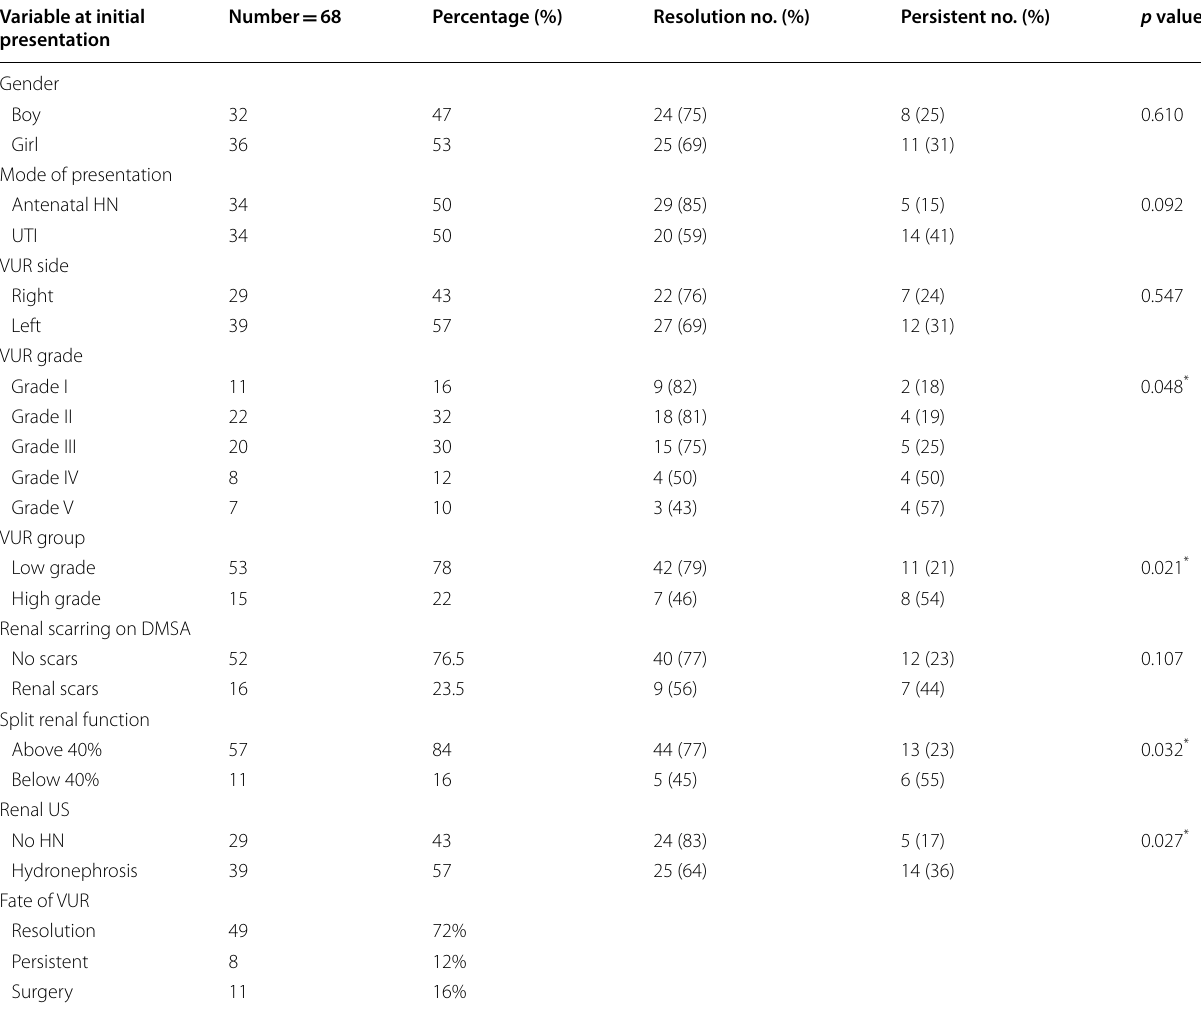
Table 1 Patient demographics, imaging characteristics and clinical outcome of 68 children with primary unilateral vesicoureteral